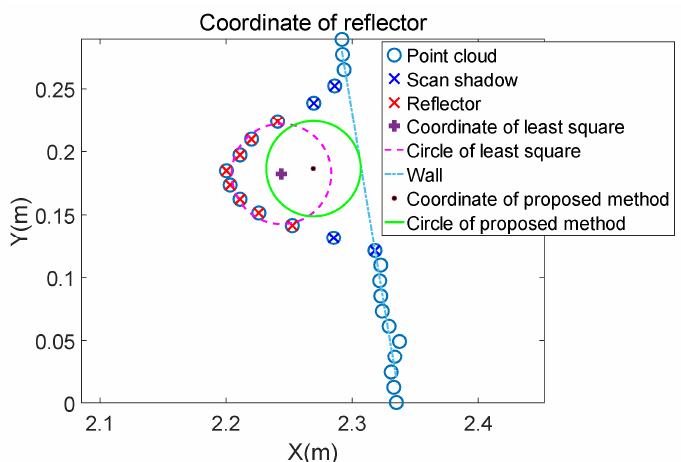
Figure 12. After modification, the final reflector coordinate is more precise than the initial one fitted by the traditional least square.